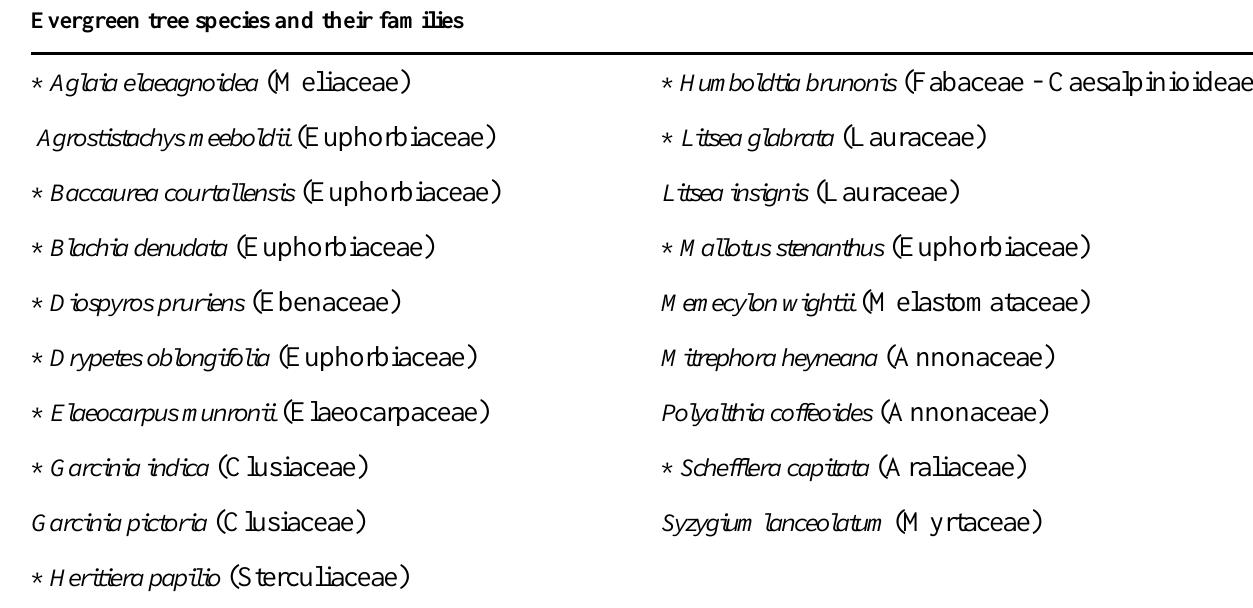
Table 5. Evergreen tree species restricted to the forest reserve in Kodagu; those marked with an asterisk are species that are also endemic to the Western Ghats of India Evergreen tree species and their